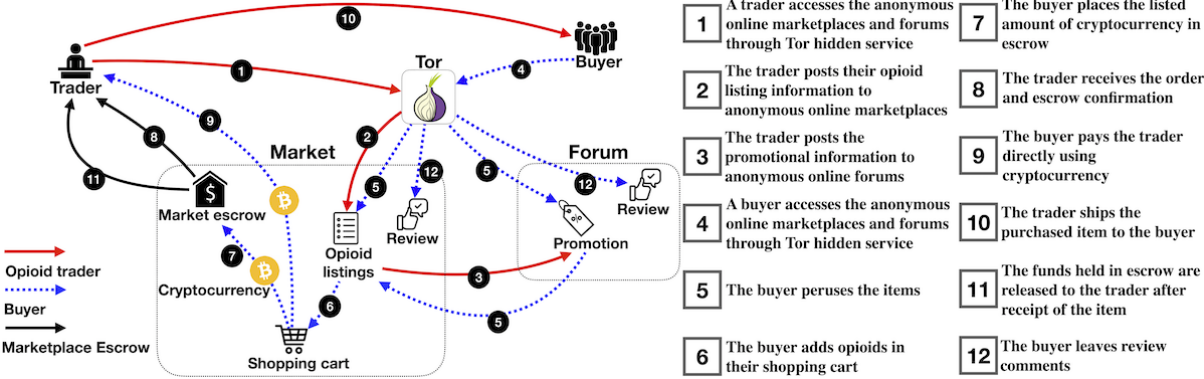
Figure 1. Overview of the opioid trading in the anonymous marketplaces and